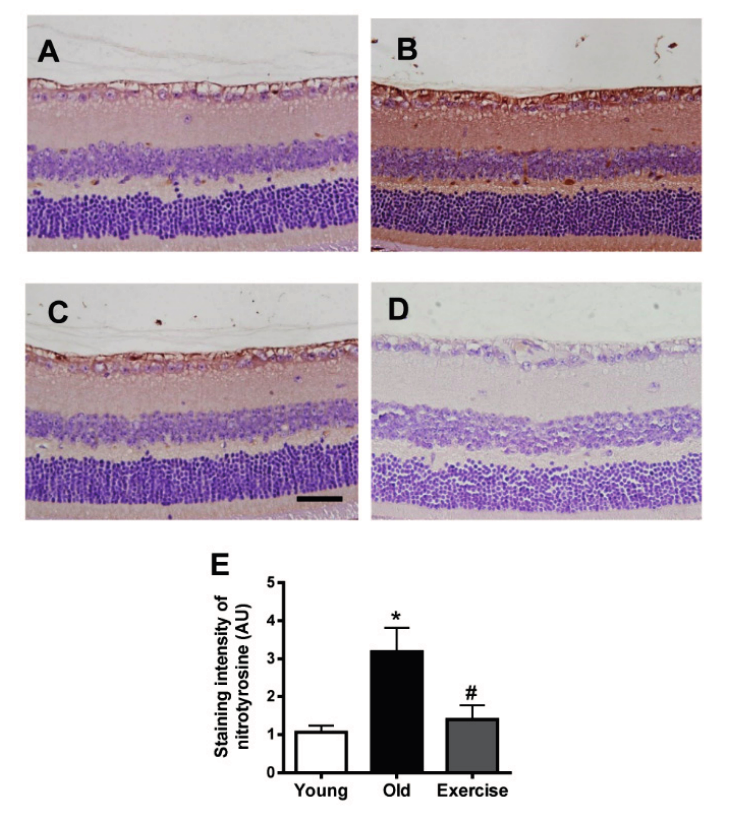
Figure 4. Retinal nitrotyrosine formation. Immunohistochemical staining for